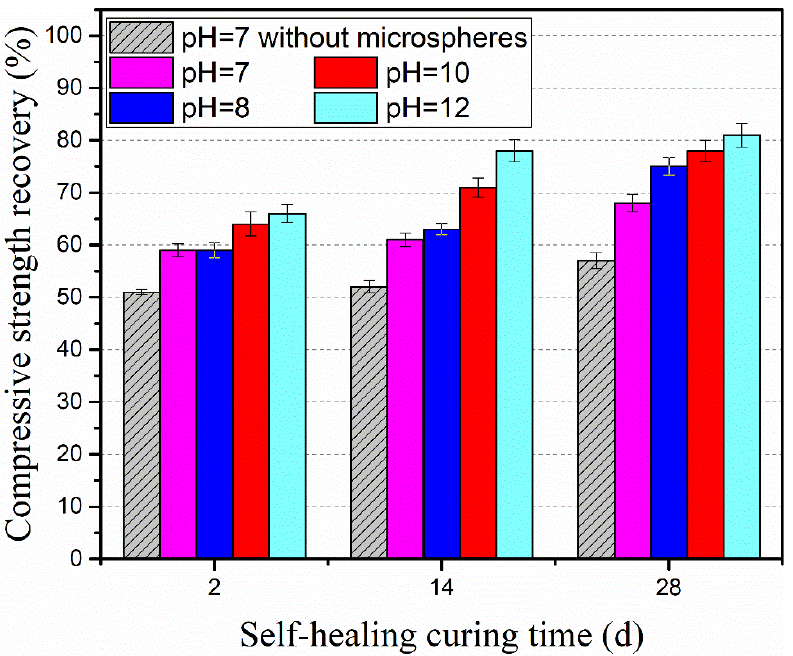
Figure 7. Recovery of compressive strength in different alkaline environments.